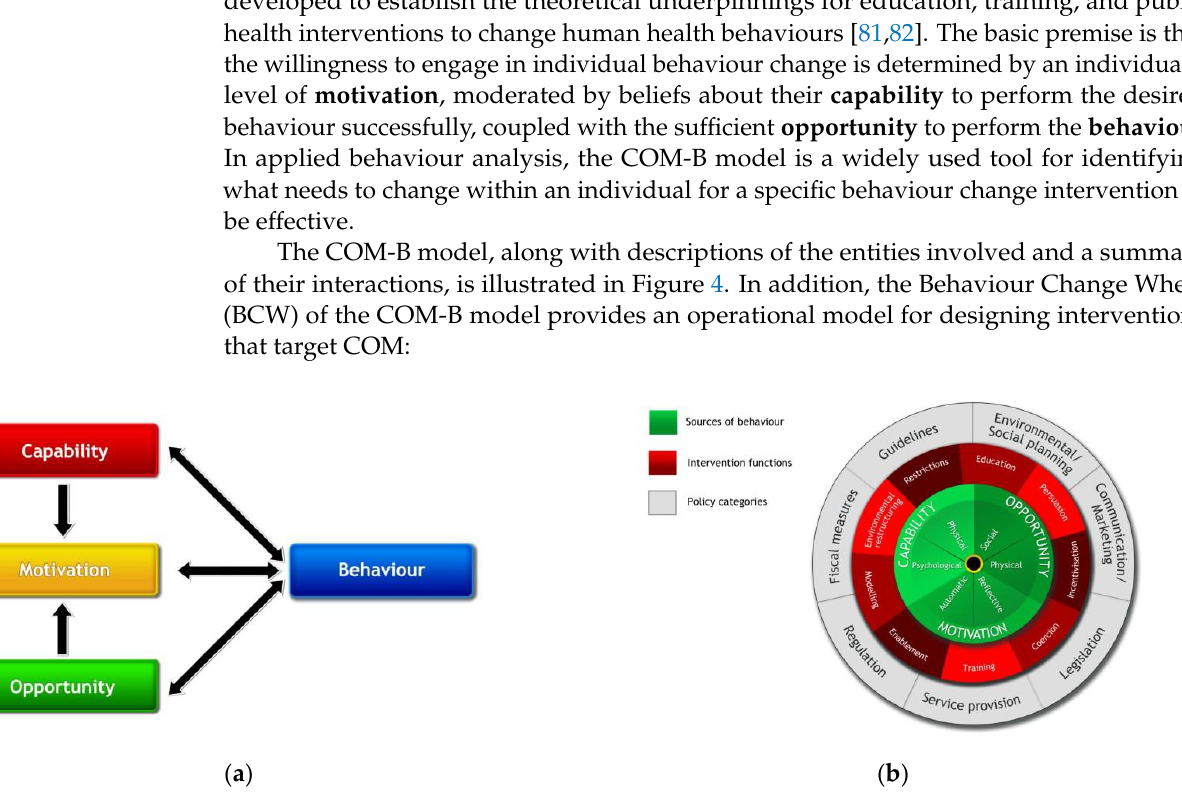
Figure 4. ( a ) The COM-B model [75]. ( b ) Behaviour Change Wheel (BCW) [75]. Physical Capability : It refers to someone’s physical capability involving their physique to carry out an activity.